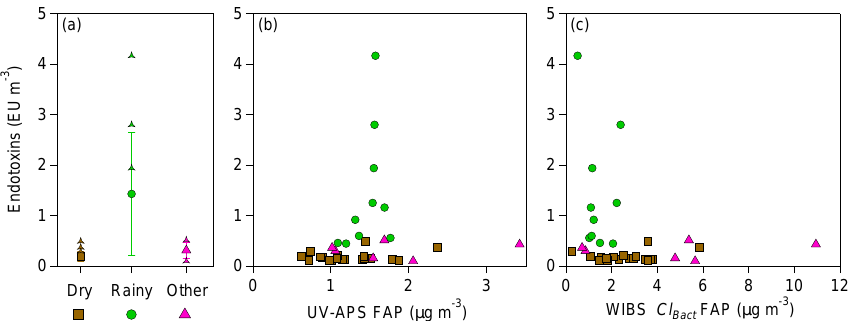
Figure 8. Endotoxin mass concentration as an approximate indicator of gram-negative bacteria concentration. (a) Averaged concentration in each wetness category. Central marker shows mean value of individual filter concentration values, bars represent standard deviation (SD) range of filter values, and individual points show outliers beyond mean ± SD. (b) Correlation of endotoxin mass concentration with estimated fluorescent particle mass from UV-APS. (c) Correlation of endotoxin mass concentration with estimated fluorescent particle mass summed from clusters 2, 3, and 4 from Crawford et al.